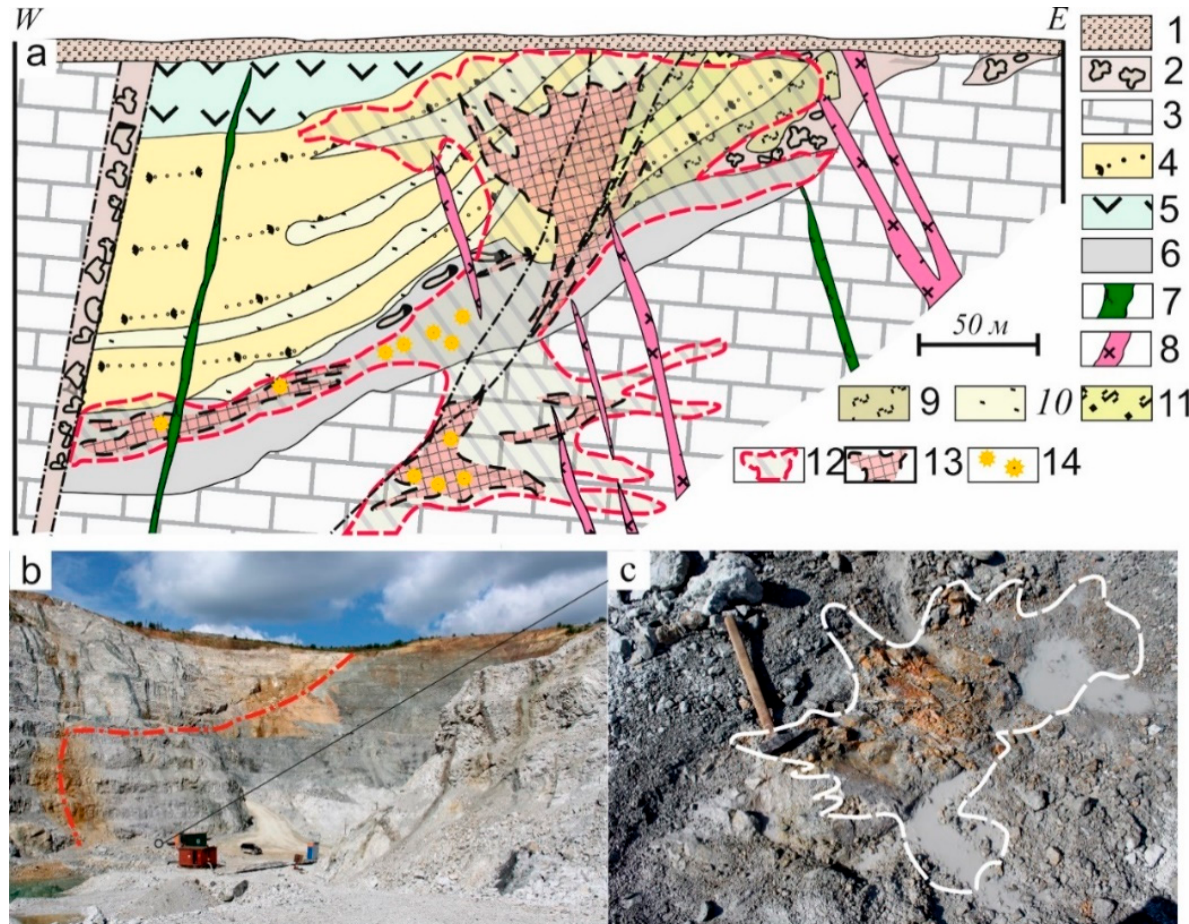
Figure 2. ( a ) Schematic section of the Vorontsovskoe deposit [15–17]; ( b ) the photograph of the northern wall of the quarry with a tectonic contact between marmorized limestone and a layer of volcanic-sedimentary rocks (red dotted line); ( c ) a small body of fluid-explosive breccias with realgar-orpiment cement (sample 2016/2), exposed in one of the quarry layers. The white dotted line shows the boundary of the body. 1—Neogene-Quaternary cover deposits; 2—karst formations; Devonian formations: 3—limestones; 4—tuff aleurolites, tuffstones, tuff-conglomerates; 5—andesites, tuffs and lava breccias; 6—breccia of the 1st stage of breccia formation; 7—lamprophyre dikes; 8—dikes of diorite porphyrites. Metasomatites: 9—quartz-sericite, 10—quartz-sericite-albite, 11—berezite-listvenites, chlorite-sericites. 12—ore bodies with run-of-mine grades of gold content; 13—enriched ore pillars; 14—manifestation areas of realgar-orpiment